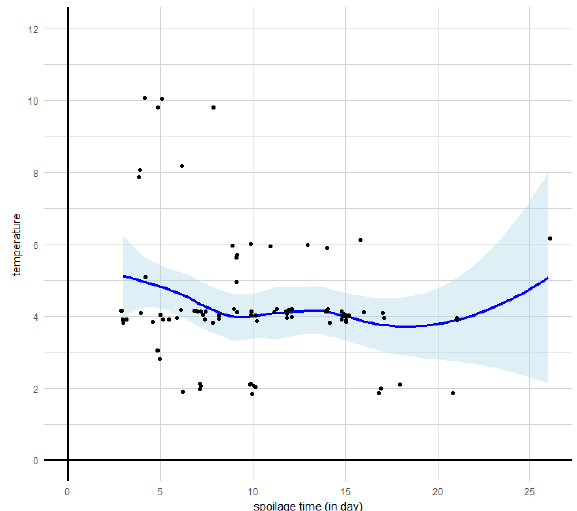
Figure 7. Spoilage occurrence time observed at different storage temperatures. The data are represented as jitter points to avoid overplotting. The thick black line represents the smooth curve obtained by LOESS local non-linear regression. The grey band corresponds to the 95% confidence interval around the smooth curve. The vertical dotted line corresponds to the median spoilage time characterizing early and belated spoilage stages.